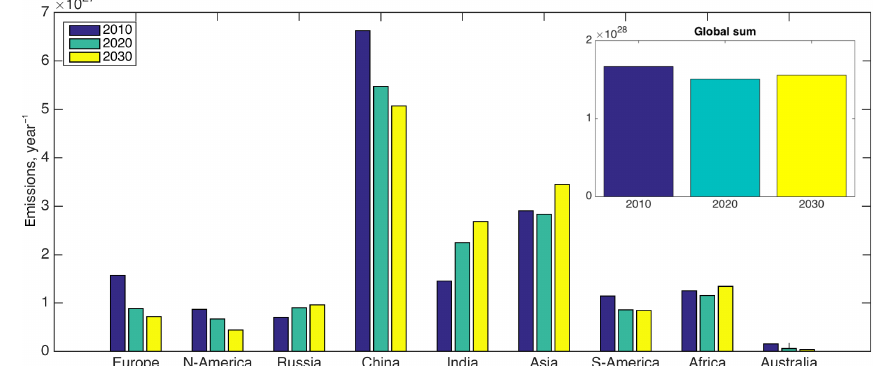
Figure 3. Evolution of continental anthropogenic particle number emissions from 2010 to 2030 according to the current legislation scenario in different parts of the world and the whole